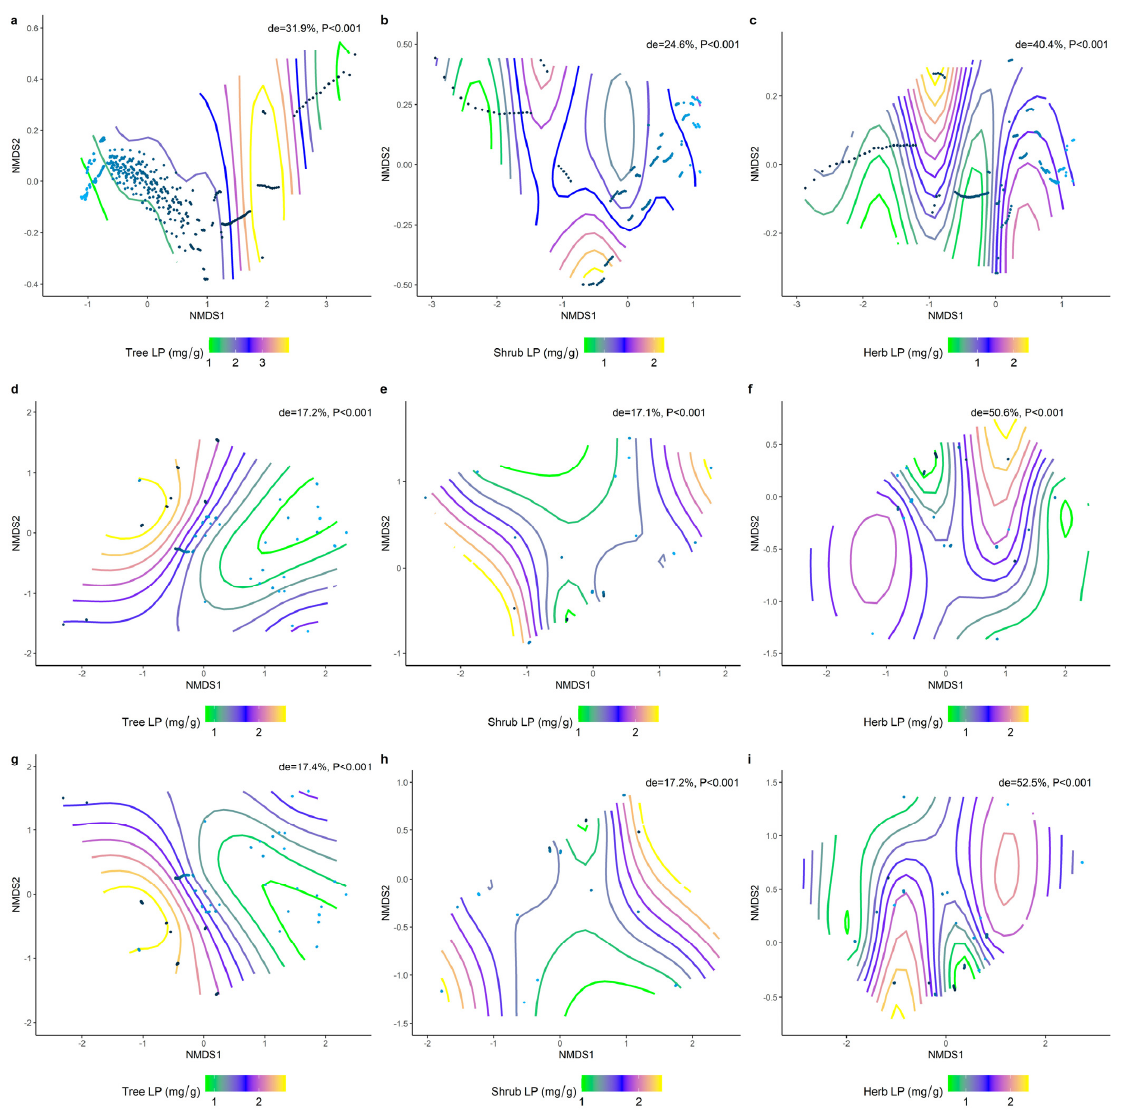
Figure 10. The NMDS ranking of climatic and soil factors with different life forms of LP. Value of de represents the deviation explained by the corresponding model. ( a ) NMDS ranking of soil factors with tree levels LP; ( b ) NMDS ranking of soil factors with shrub levels LP; ( c ) NMDS ranking of soil factors with herb levels LP; ( d ) NMDS ranking of climatic factors with tree levels LP; ( e ) NMDS ranking of climatic factors with shrub levels LP; ( f ) NMDS ranking of climate factors and herb levels LP; ( g ) NMDS ranking of the sum of soil factors and climate factors and tree levels LP; ( h ): NMDS ranking of the sum of soil factors and climate factors and shrub levels LP; ( i ): NMDS ranking of the sum of soil factors and climate factors and herb levels LP. Trait stacking indicates that abiotic factors, indicated by points on the NMD, are associated with higher or lower trait values, consistent with a colored trait gradient. Note that if the relationship between LP and abiotic factors is linear, the gra- dient splines will be parallel. Nonlinear relationships between LP and abiotic factors are represented by curve splines.